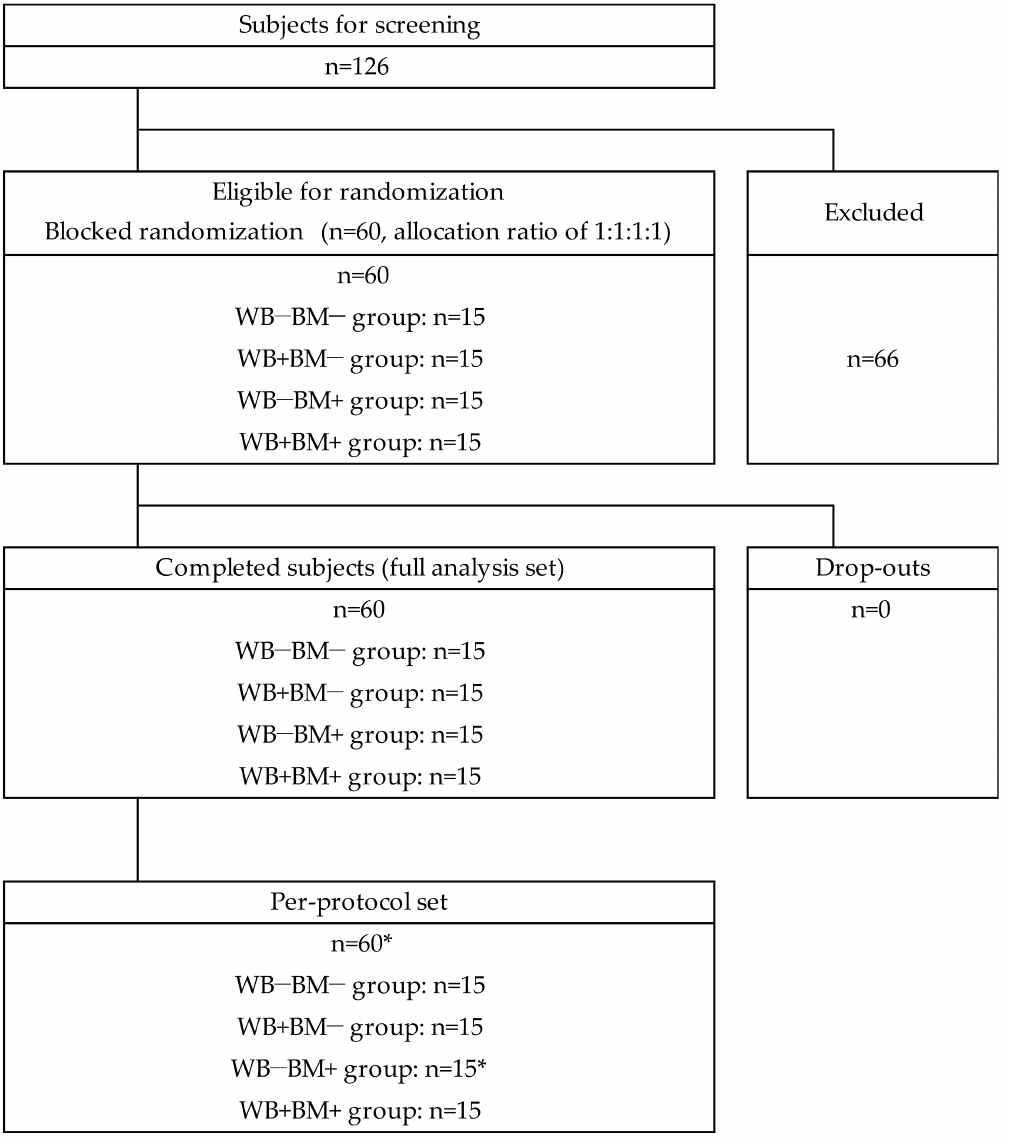
Figure 1. Scheme of participant